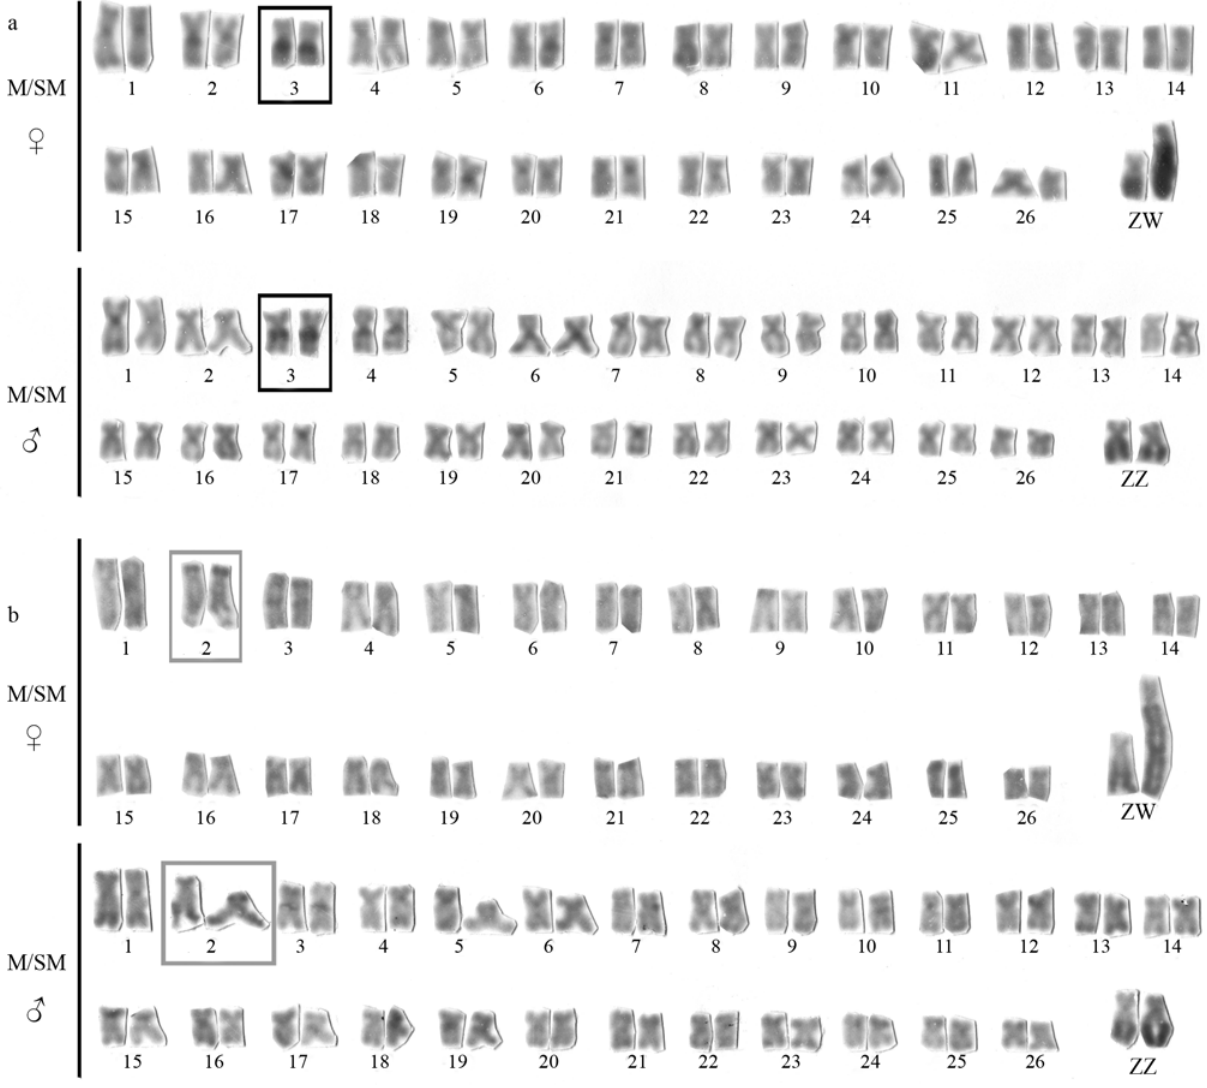
Figure 2 - C-banded karyotypes (female and male) of Leporinus macrocephalus (Piauçu) (a) and Leporinus elongatus (Piapara) (b). The marker chromo- somes are shown in detail (inbox).